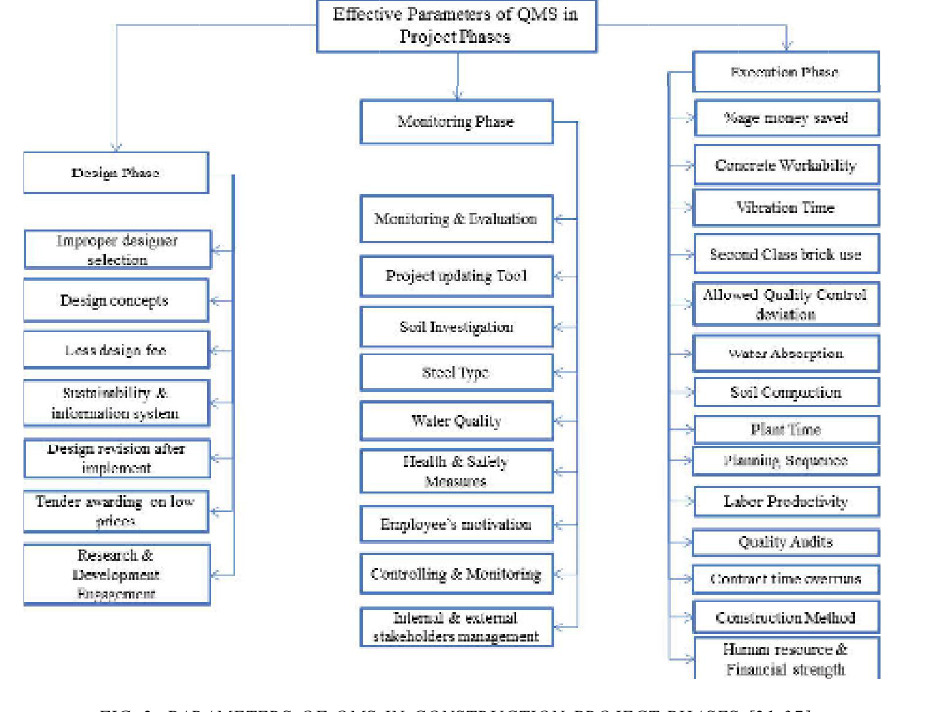
FIG. 2. PARAMETERS OF QMS IN CONSTRUCTION PROJECT PHASES